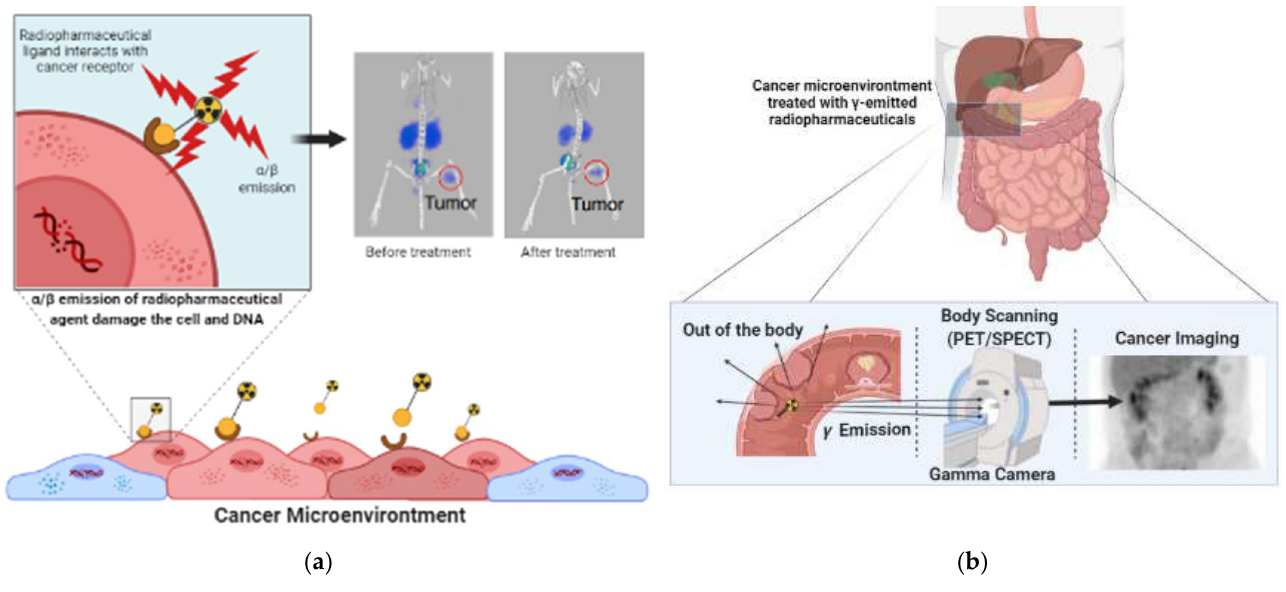
Figure 2. The illustration of radiopharmaceutical use for cancer therapy and diagnosis: ( a ) The utilization of alpha- and beta-emitted radiopharmaceuticals for cancer therapy [8]. ( b ) The utilization of gamma-emitted radiopharmaceuticals for cancer diagnosis (imaging).